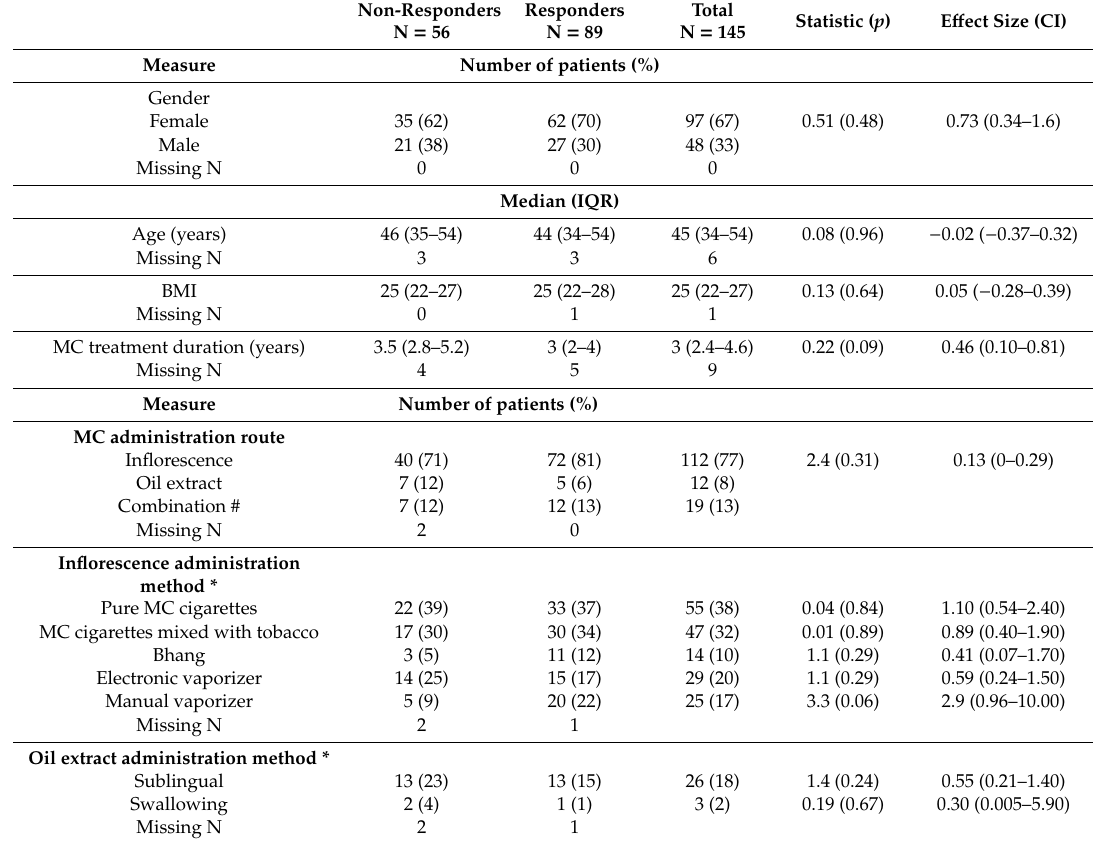
Table 1. Demographic and medical cannabis (MC) treatment characteristics.